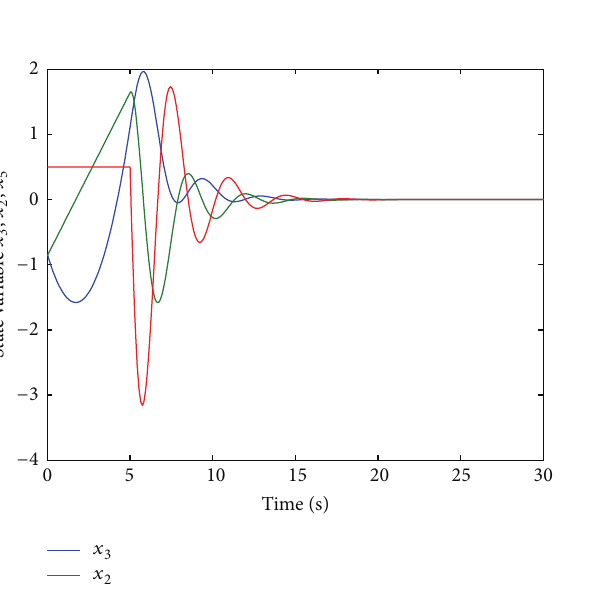
Figure 4: Original state variables 𝜃 , 𝜔 .